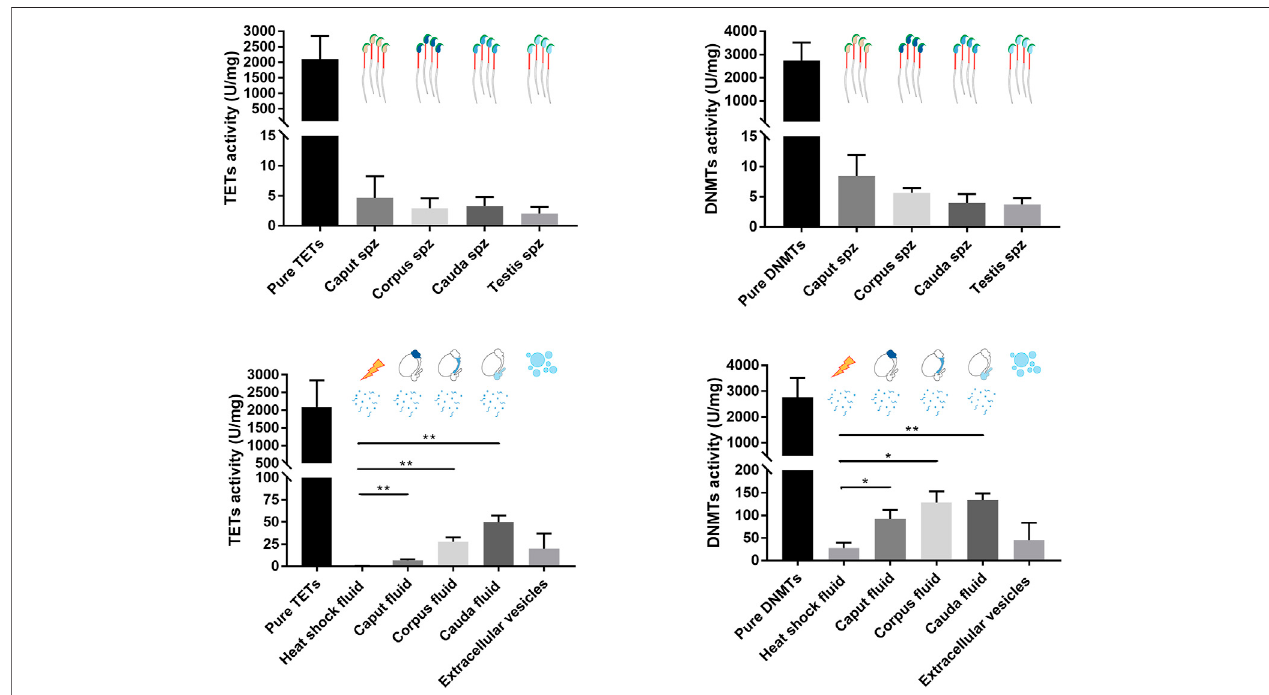
FIGURE 8 | TET and DNMT enzyme assays performed on spermatozoa, epididymal fl uid, and extracellular vesicle samples. Nuclear protein extracts from caput , corpus , and cauda spermatozoa, and epididymal fl uid from different segments were used for TET and DNMT enzyme assays. Results are representative of three independentexperiments.Totalenzymeactivitiesweredetectedineachsample(mean±SEM).Pureenzymesand cauda epididymal fl uiddenaturedbyheatshockwere used as positive and negative controls, respectively. Spz: spermatozoa. * and ** represent signi fi cant differences p < 0.05 and < 0.005, respectively.